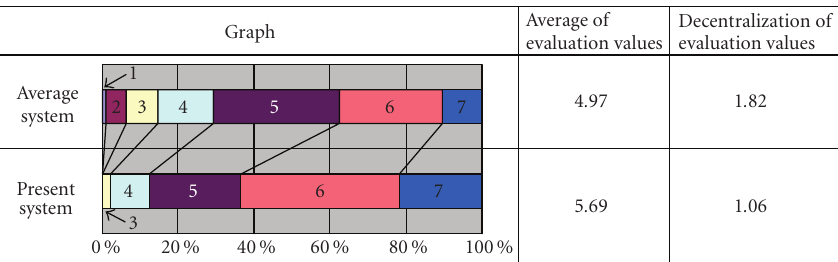
Figure 9: Distributions of evaluation values.